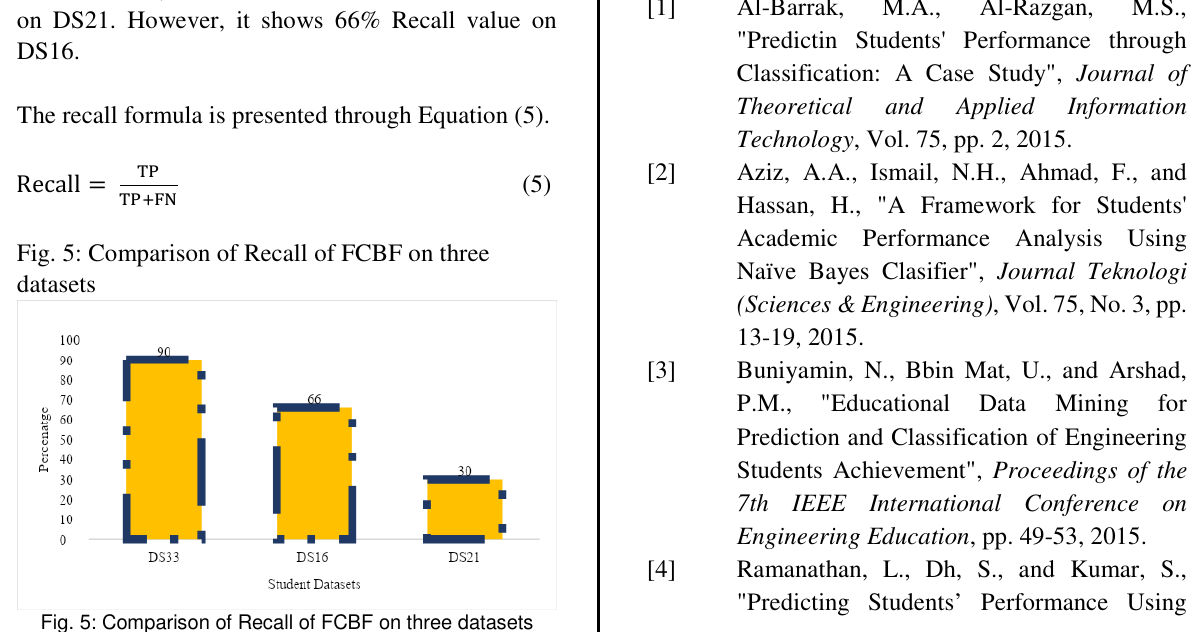
Fig. 5: Comparison of Recall of FCBF on three